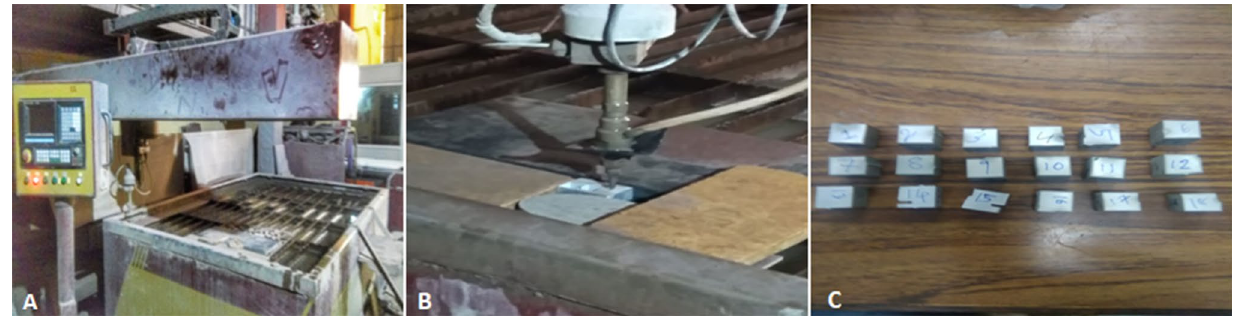
Fig.4 AAJ machining